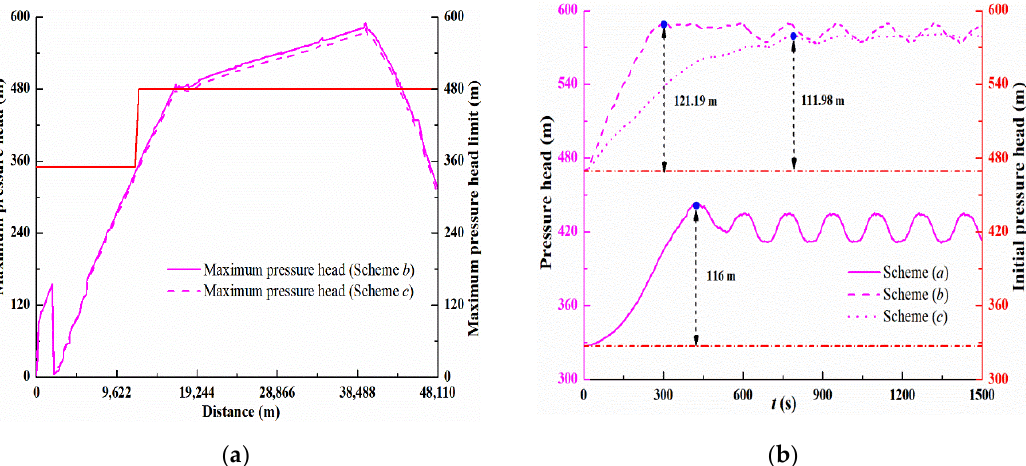
Figure 6. ( a ) Pressure head change along the pipeline in schemes b and c; ( b ) pressure head change at maximum pressure head point behind energy dissipation box in schemes a, b, and c.